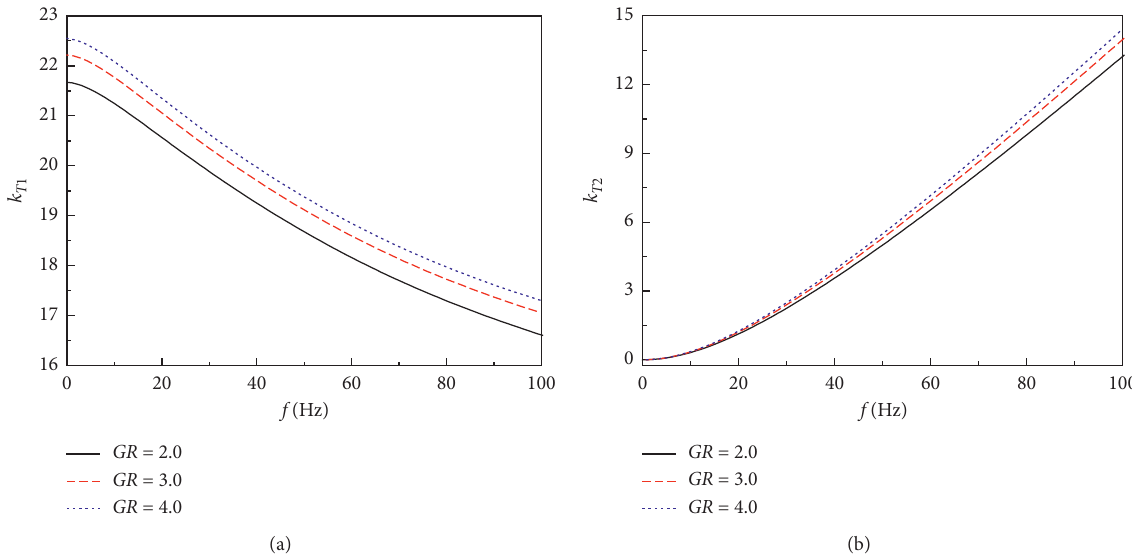
Figure 6: Influence of the shear modulus ratio GR � G ( D sm � D s 0 � 0, t m / r 0 �